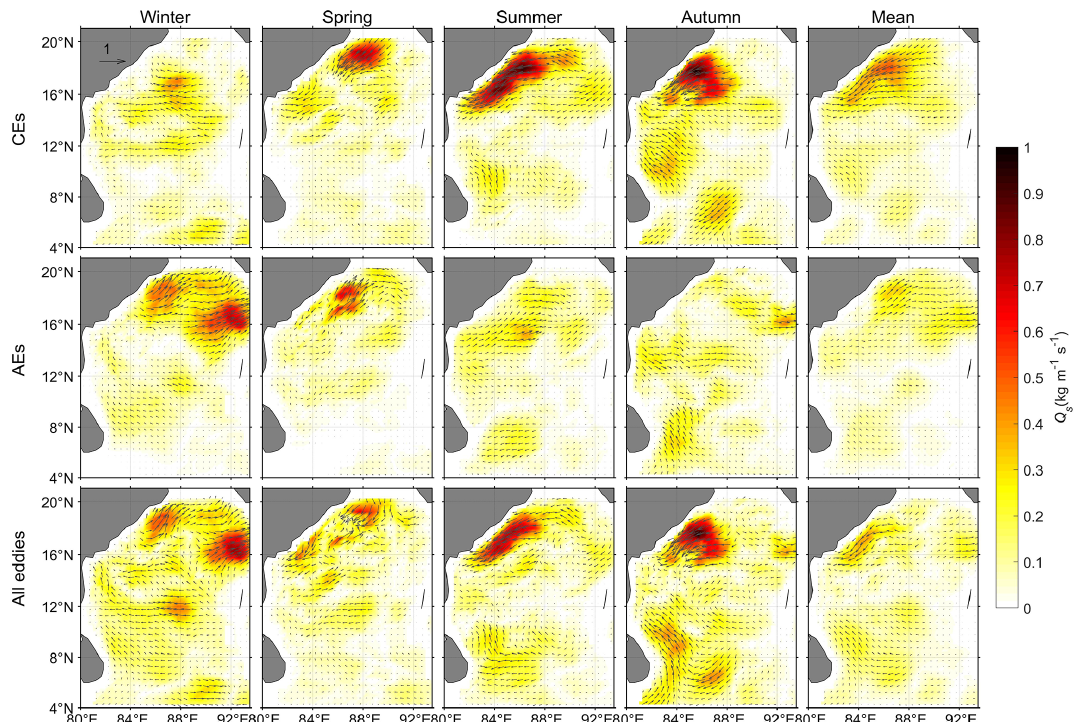
Figure 12. Seasonal eddy-induced salt transport Q s in the Bay of Bengal: results for cyclonic eddies (CEs) (upper row), results for anti- cyclonic eddies (AEs) (middle row), and results for all eddies (bottom row). Here, Q s = (Q sm ,Q sz ) is a vector whose components are the meridional and zonal salt transports, the arrows indicate the transport direction, and the color indicates the transport